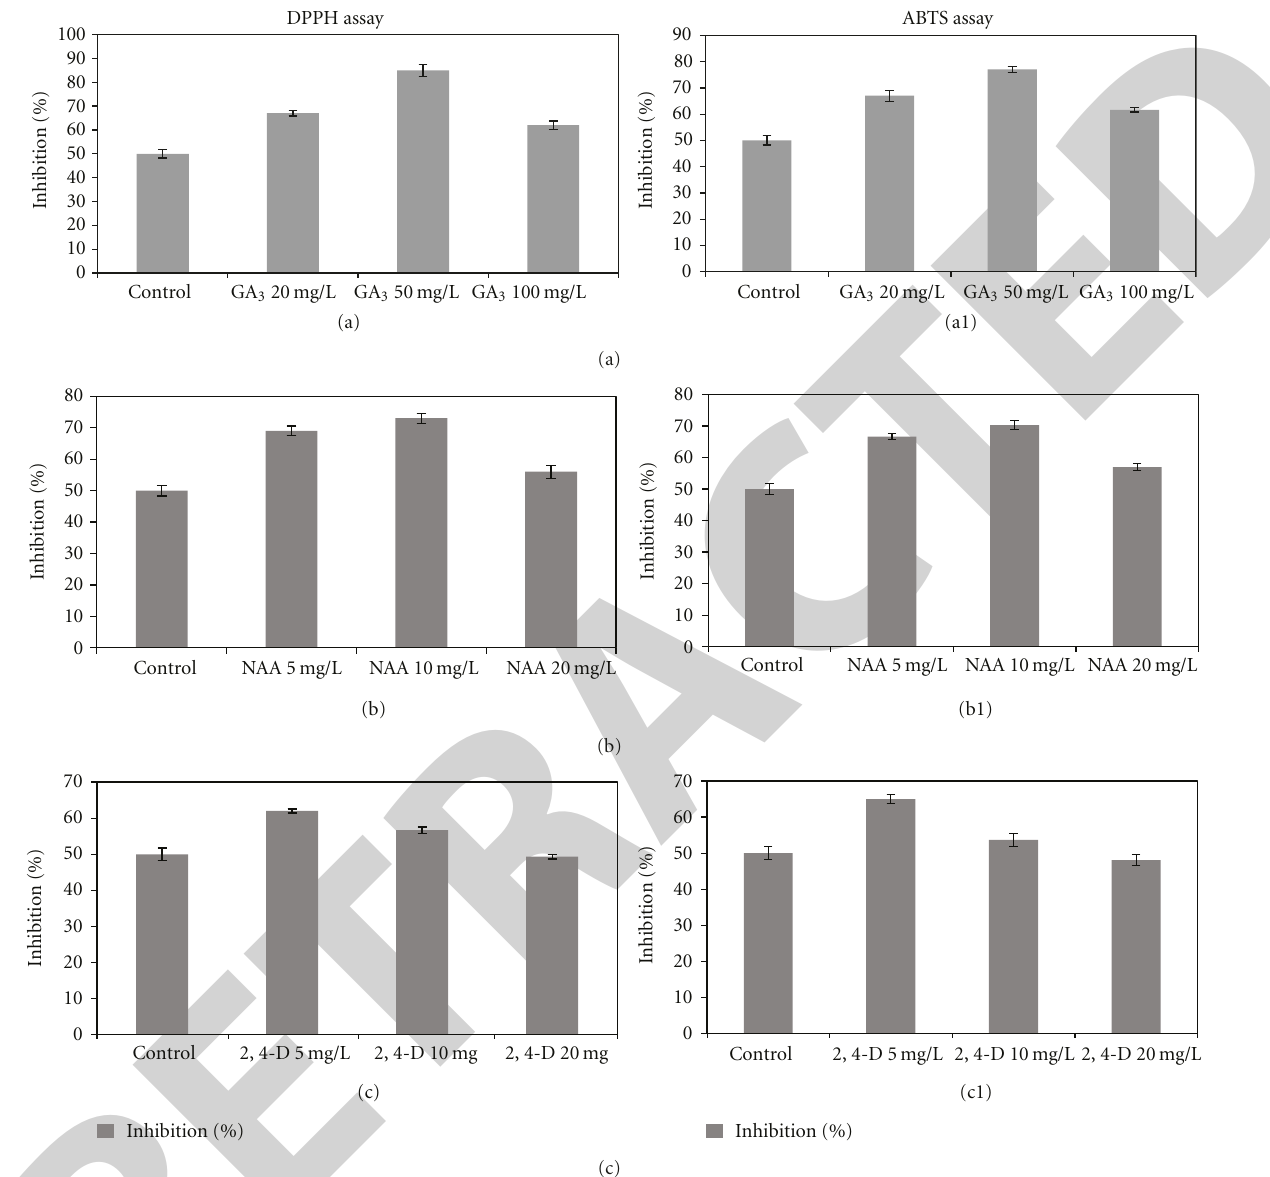
Figure 1: Changes in antioxidant activity: (a) and (a1) GA 3 treated, (b) and (b1) NAA treated, (c) and (c1) 2,4-D treated wax apple fruits using the DPPH and ABTS assays. Vertical bars represent the LSD at the 5%